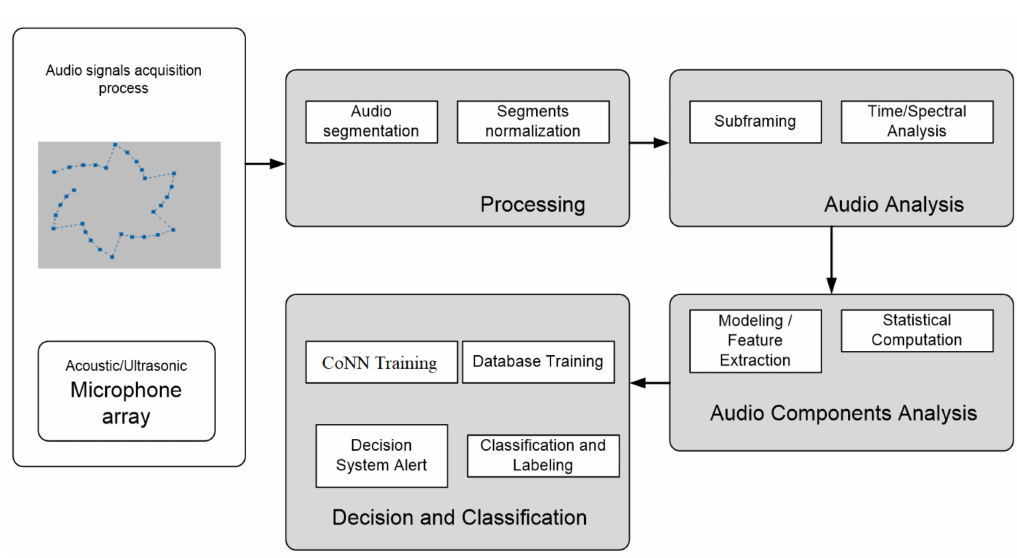
Figure 2. Proposed System’s Software